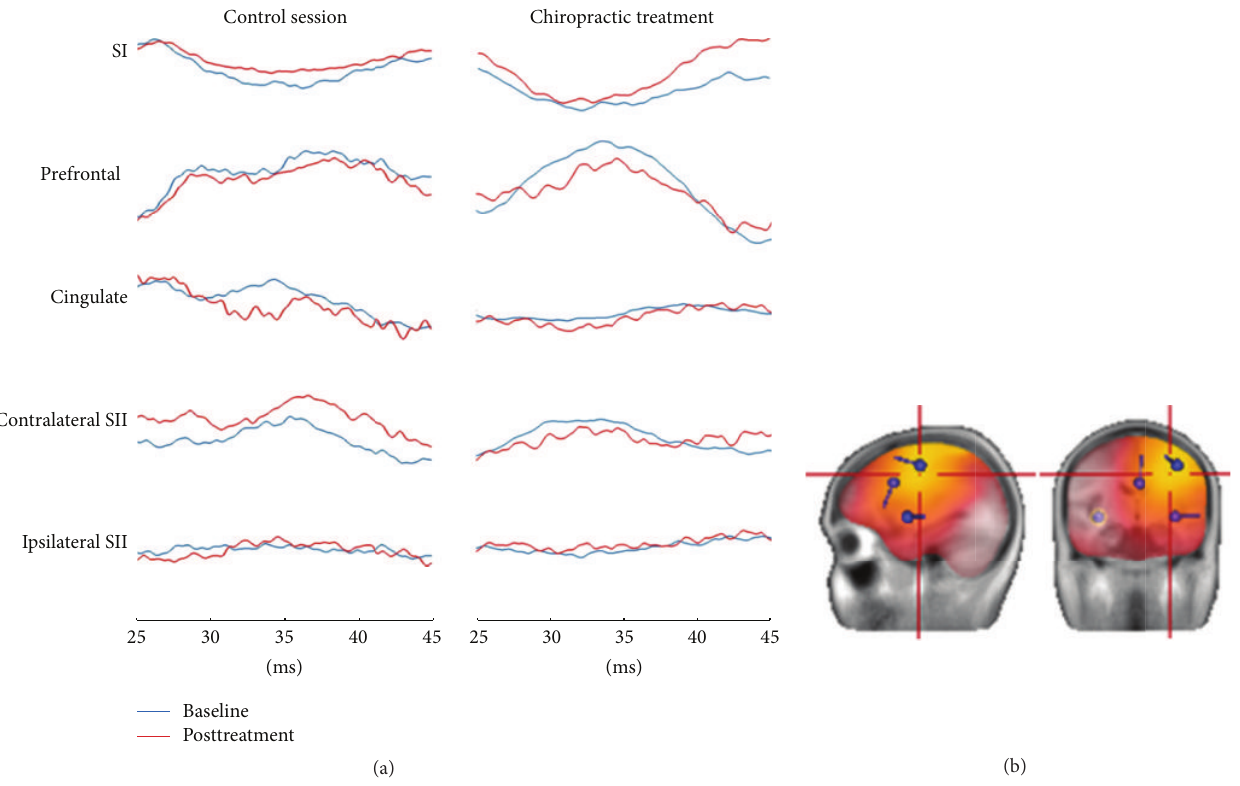
Figure 2: Source localization and activity. (b) are the dominant sources and (a) are their waveforms of activity. The plot is of one representative